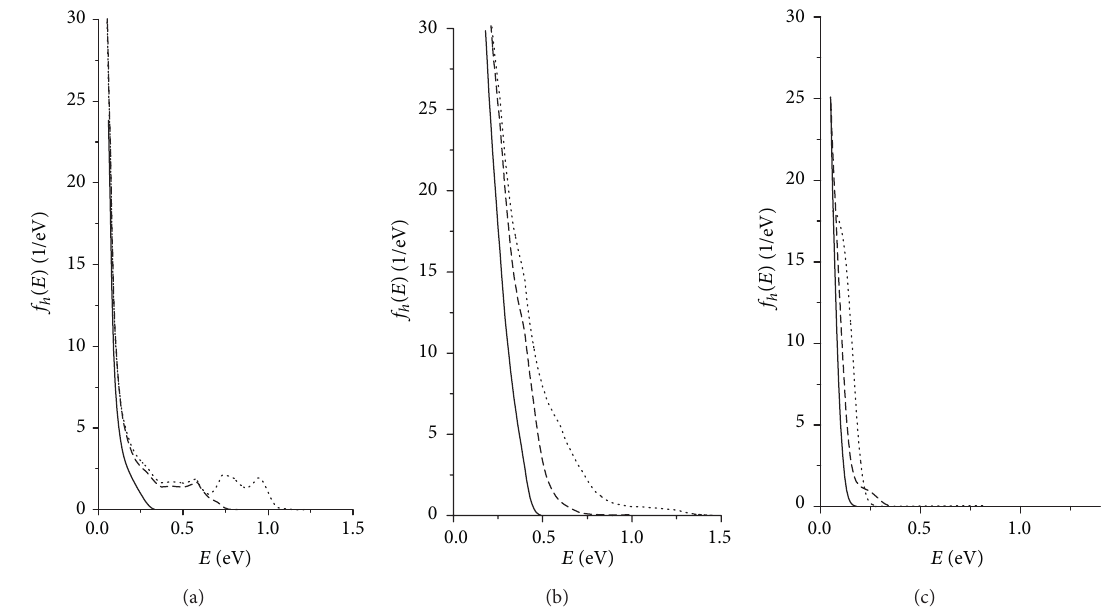
Figure 6: The calculated distribution function of holes in anatase (a), rutile (b), and zinc oxide (c). In solid lines the data are shown for the photon energy of 3.5 eV, in dashed lines the data are shown for 4.0 eV, and in point lines the data are shown for 4.5 eV. It is assumed that (𝑡) = 1 . 𝑆 0